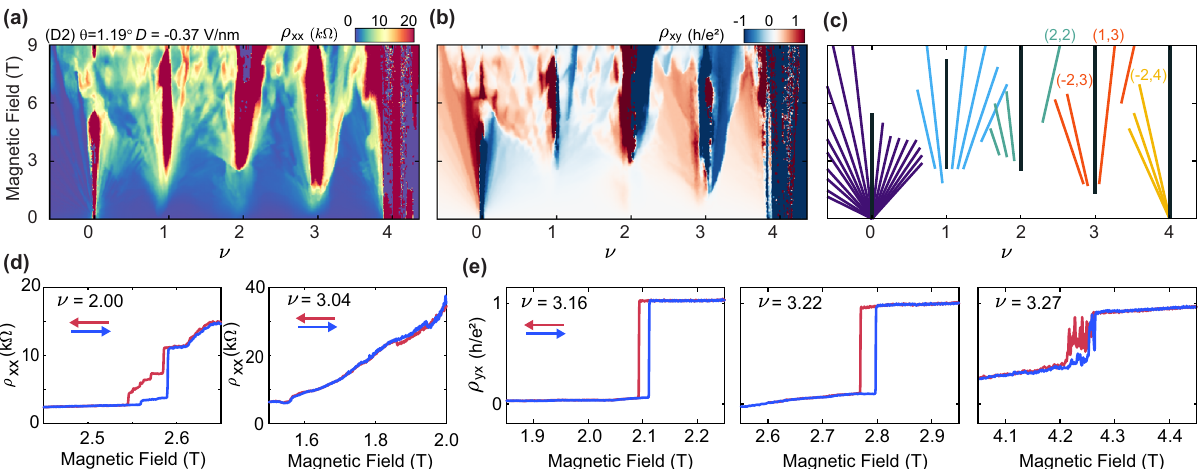
Fig. 4 First-order orbital phase transitions at the high fi eld for D < 0. a , b Landau fan diagram of ρ xx ( a ) and ρ xy ( b ) for device D2 at D = − 0.37 V/nm, acquired at T = 0.1 K. c Schematic representation of the observed states, following the convention established in Fig. 3. A subset of the most robust gapped states we observe are labeled by their respective ( t , s ) indices. States at all integer t are observed for s = 0 and 1, indicating full degeneracy lifting. d ρ xx acquired as B is swept back and forth at ν = 2.00 (left) and ν = 3.04 (right). e ρ yx acquired as B is swept back and forth at ν = 3.16 (left), ν = 3.22 (middle), and ν = 3.27 (right). Data in ( d , e ) are acquired at T = 0.1